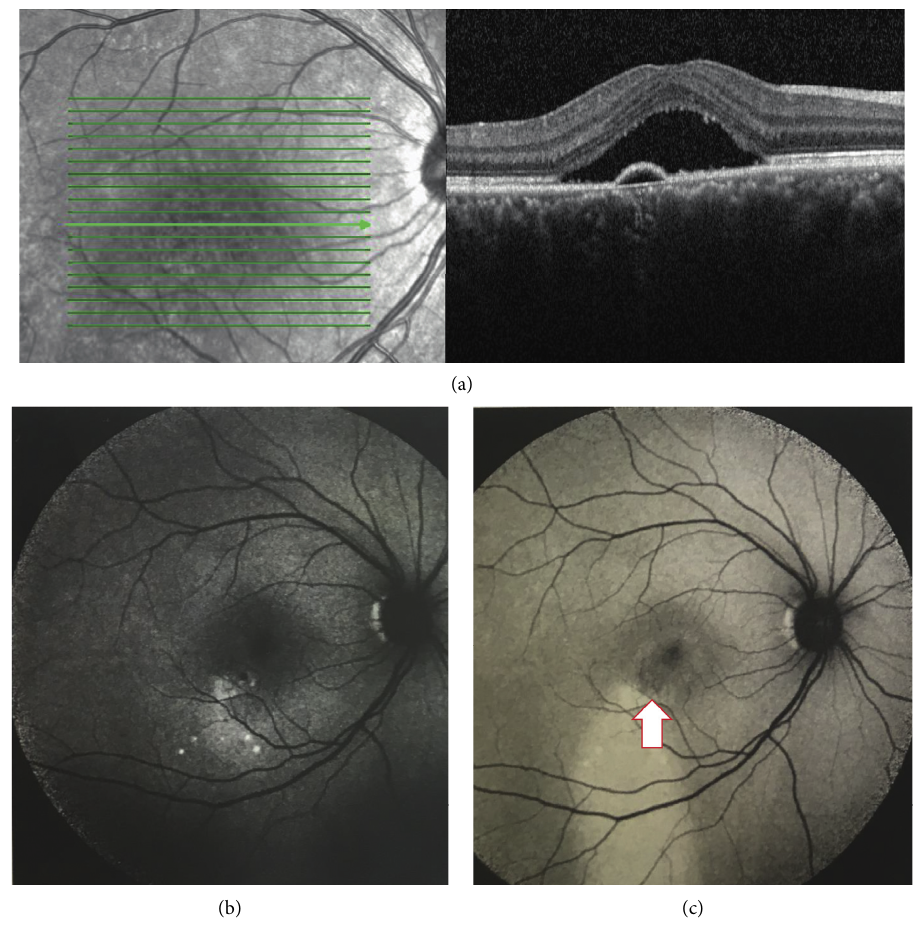
Figure 1: (a) SD-OCT line scan with evidence of PED at the site of leak. (b) 50-degree fundus autofluorescence scan shows a discrete hypofluorescence signal at a background of increased fluorescence at acute stage. (c) The FAF imaging of the same patient with late-chronic CSC at 6 months after symptoms onset. Given the cross-sectional study design, only the first FAF imaging and the presenting OCT scans were included for the statistical analysis. The FAF scan shows a less discrete hypofluorescence signal at the site of leak and a presence of water track